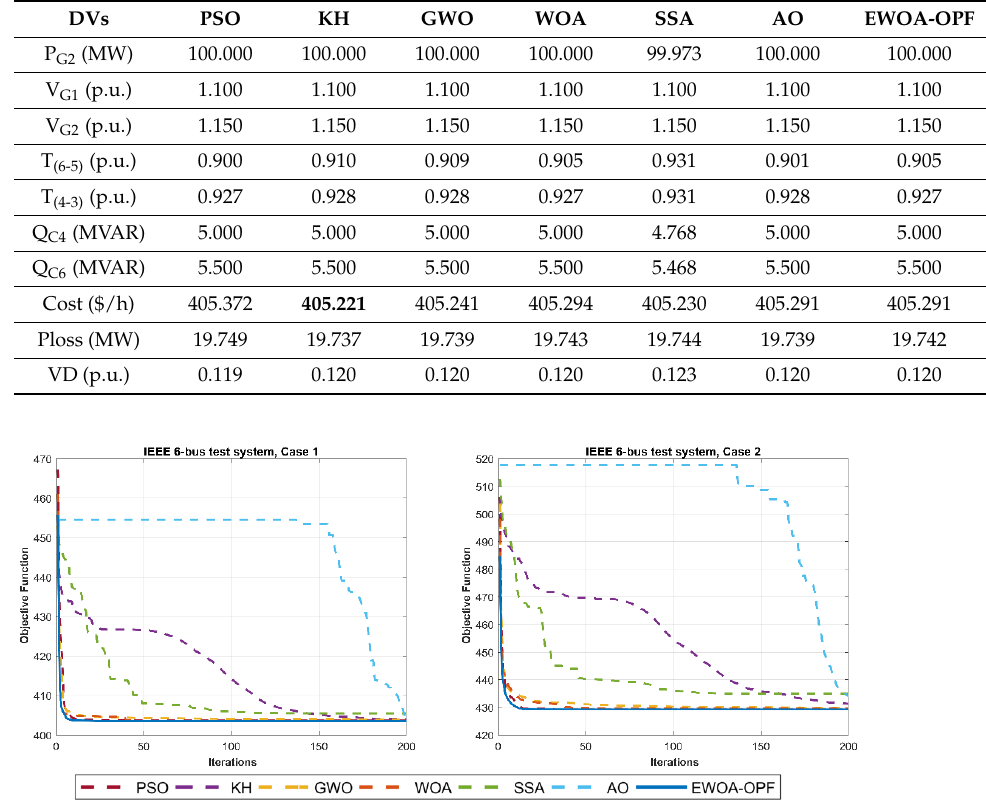
Figure 2. Curves for all test systems on Cases 1 and 2.